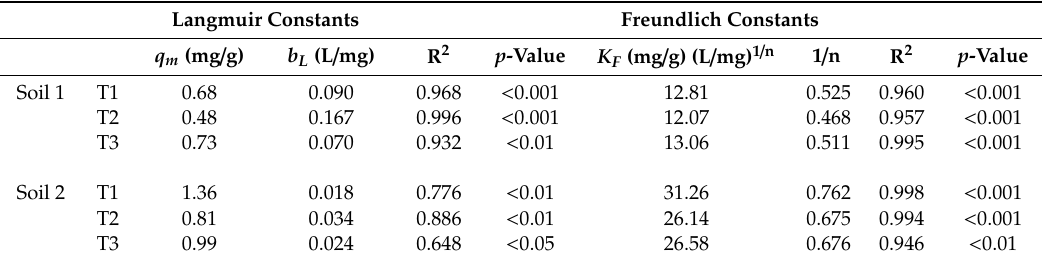
Table 3. Parameters of the Langmuir and Freundlich models for P sorption in the two soils. Contact time 24 h, agitation rate 125 rpm, sorbent / solution ratio 1 g / 0.02 L, P concentrations at start time from 2.36 to 88.88 mg / L, temperature 22 ◦ C. T1: triple superphosphate in water, T2: triple superphosphate